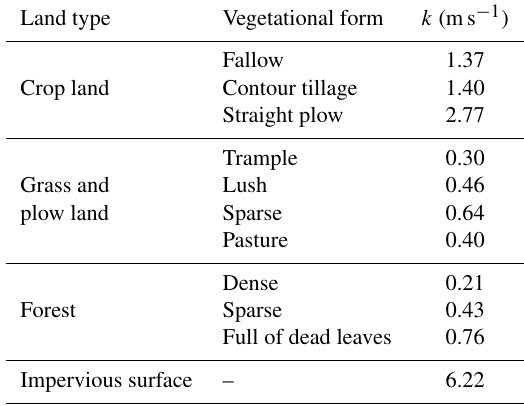
Table 3. Specific values of k for different vegetational types. Land